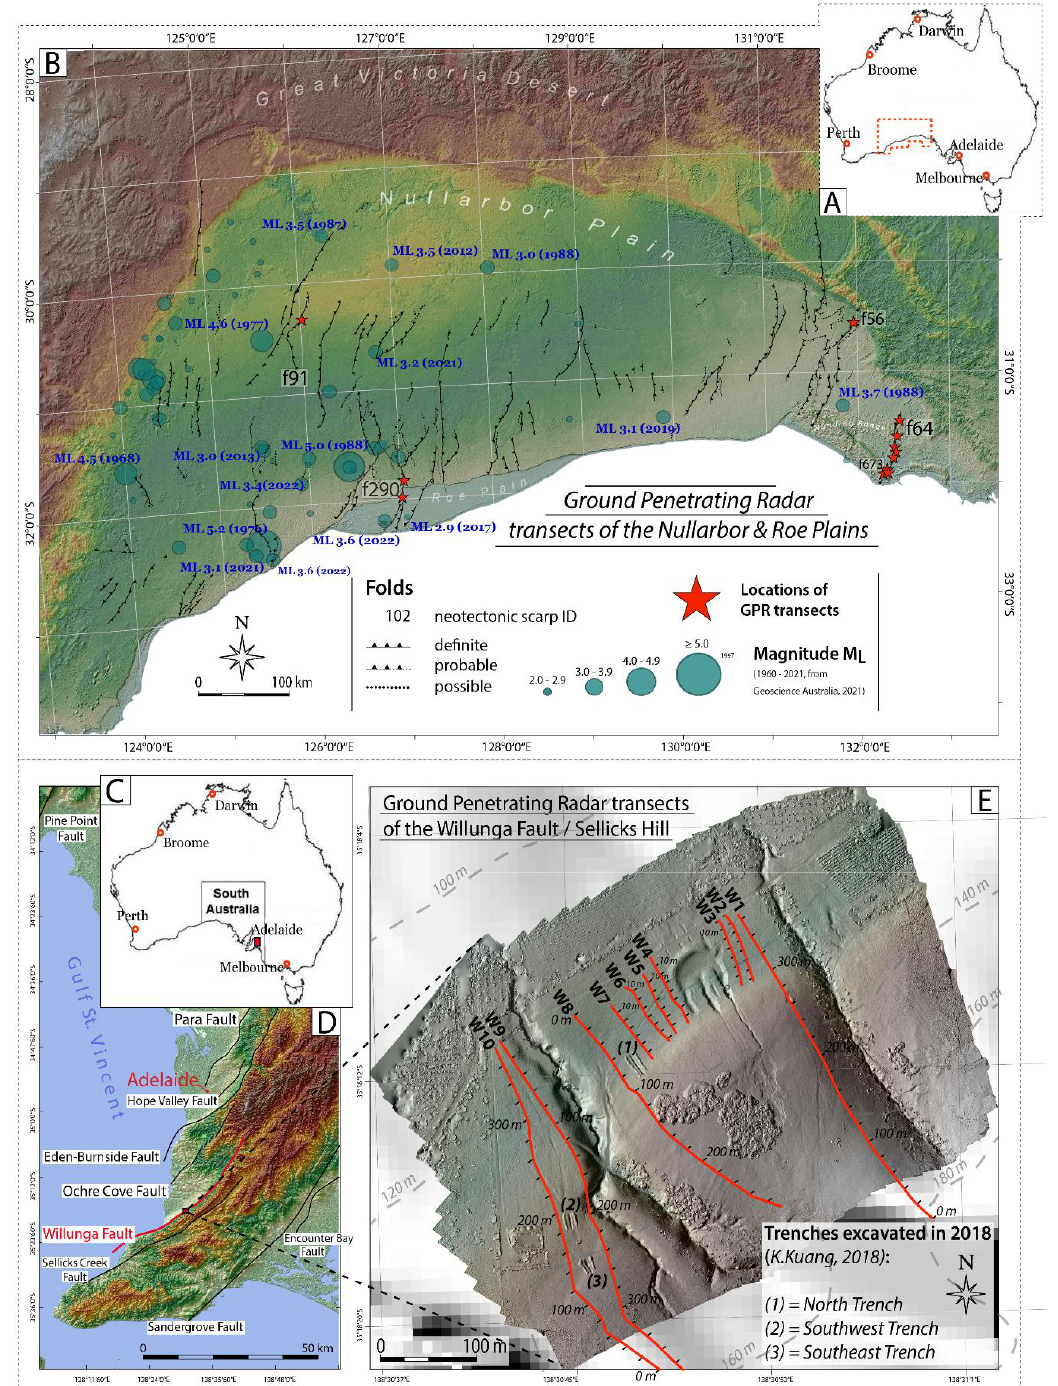
Figure 1. Maps of the Nullarbor & Roe Plains (Western and South Australia) and the Willunga Fault in South Australia showing ( A ) the location of the Plains within Australia, ( B ) the locations of GPR transects conducted on the Nullarbor and Roe Plains, interpreted neotectonic fold scarps (adapted from [17]), and historic earthquakes of Mw > 2.0 (1960–2021), ( C ) the location of the Willunga Fault field site within South Australia, ( D ) the Willlunga fault and field site in the context of the Mount Lofty Ranges and other range bounding faults (adapted from [18]), ( E ) high-resolution 10 cm DEM of the Willunga Fault field site (adapted from [18]) showing locations of the GPR transects collected in this study and trenches excavated in 2018 [18] (1) = North Trench, (2) = Southwest Trench, (3) = Southeast Trench (e.g.,